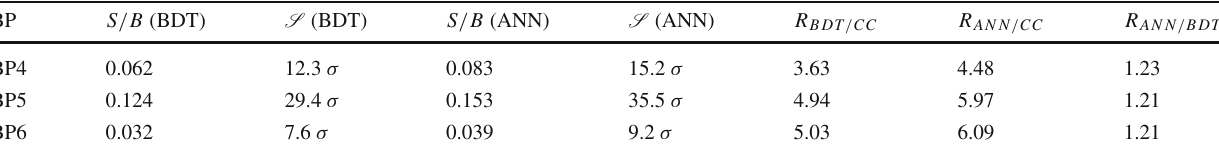
Table 10 The S / B ratio and signal significance for the